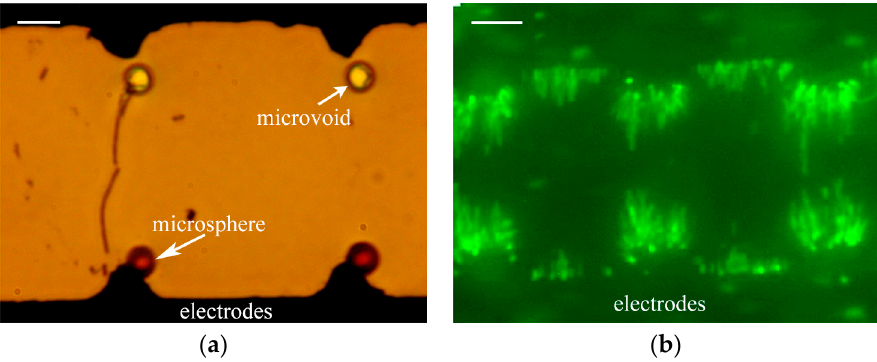
Figure 7. Photographs of two kinds of dielectrophoresis microfluidics chips with thin observation interfaces: ( a ) optical images of red trapped polystyrene (PS) microspheres in micro fl uidic chip, scale bar: 5 μ m; and ( b ) fluorescence images of trapped bacteria in micro fl uidic chip, scale bar: 10 μ m.